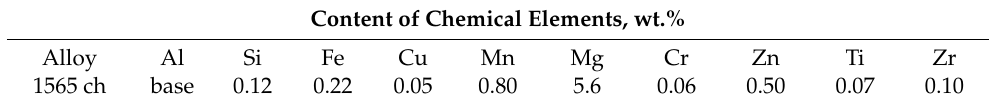
Table 1. Chemical composition of the 1565 ch alloy (AlMg 6 Mn 0.7 ). Content of Chemical Elements, wt.%